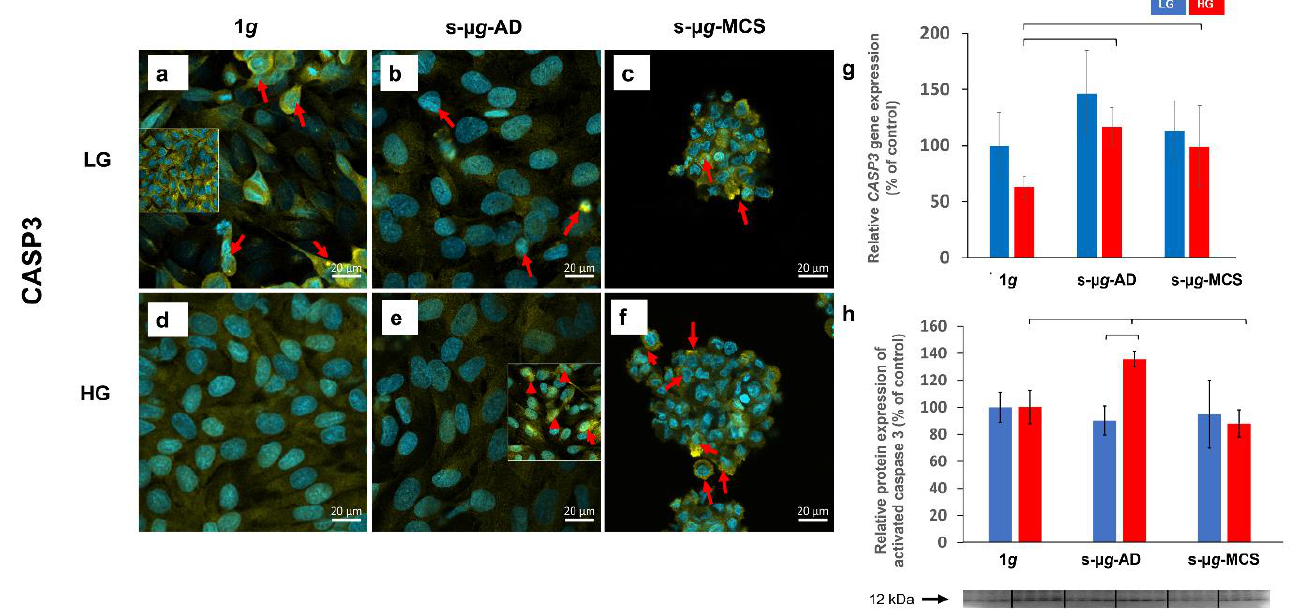
Figure 10. Analysis of CASP3 after 14 days of cultivation either at 1 g or s- µ g , either using low (LG) or high (HG) glucose medium. Data were obtained via immunostaining ( a – f ), qPCR ( g ), and Western blot ( h ). The brackets represent a significance level of p < 0.05.